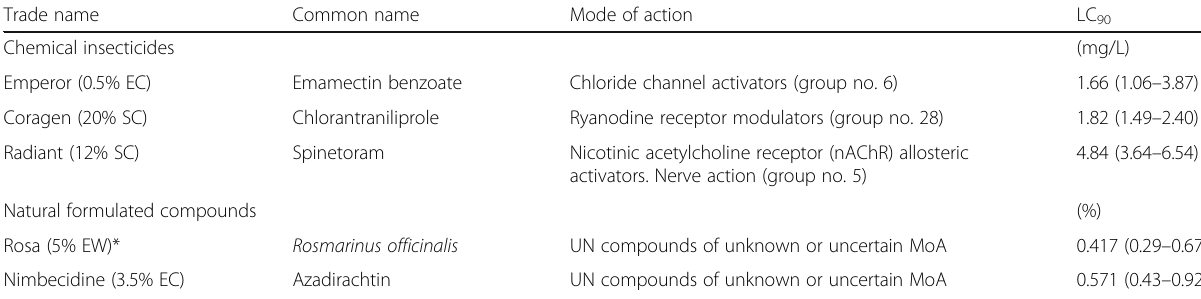
Table 1 Toxicity of tested commercial insecticides against the 2nd instar larvae of Tuta absoluta using leaf dipping